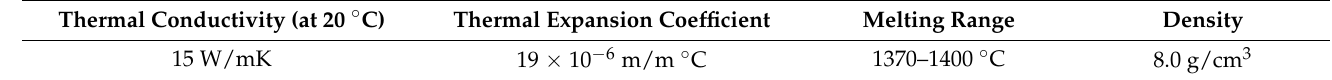
Table 3. Thermophysical properties of SUS 316L powder.